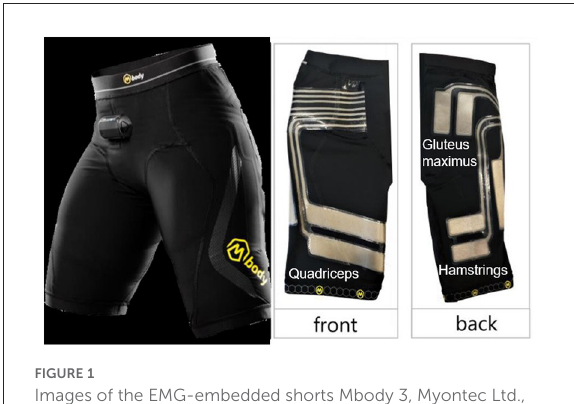
FIGURE1 Images of the EMG-embedded shorts Mbody 3, Myontec Ltd., Kuopio, Finland. Front showing the electrodes for quadriceps and the back showing electrodes for hamstrings and gluteus maximus